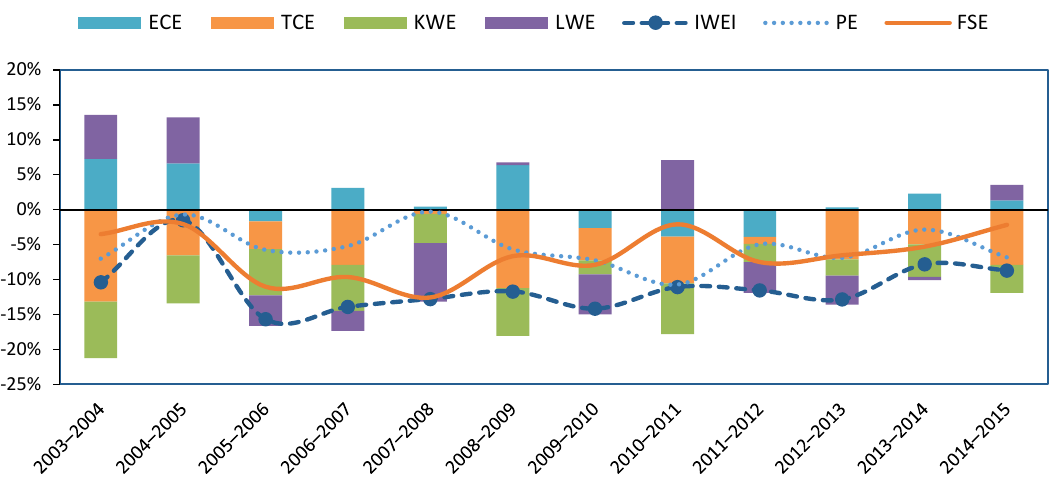
Figure 4. Driving factors of IWEI change at the national level, 2003–2015. ECE: the effect of technical efficiency change; TCE: the effect of technological change; KWE: the effect of capital–wastewater substitution; LWE: the effect of labor–wastewater substitution; IWEI: industrial wastewater emission intensity; PE: productivity effect; FSE: factor substitution effect.